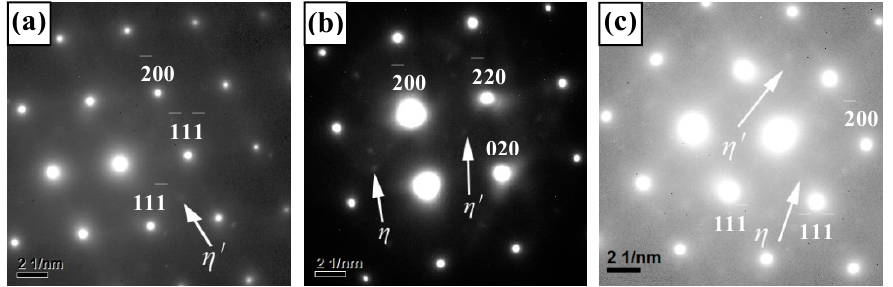
Figure 11. TEM images of the weld center aged at 130 °C for different times ( a ) 12 h; ( b ) 24 h; ( c ) 28 h.